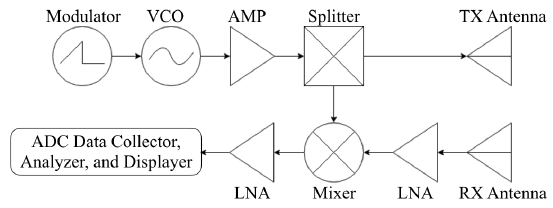
Figure 1. Basic frequency-modulated continuous-wave (FMCW) radar